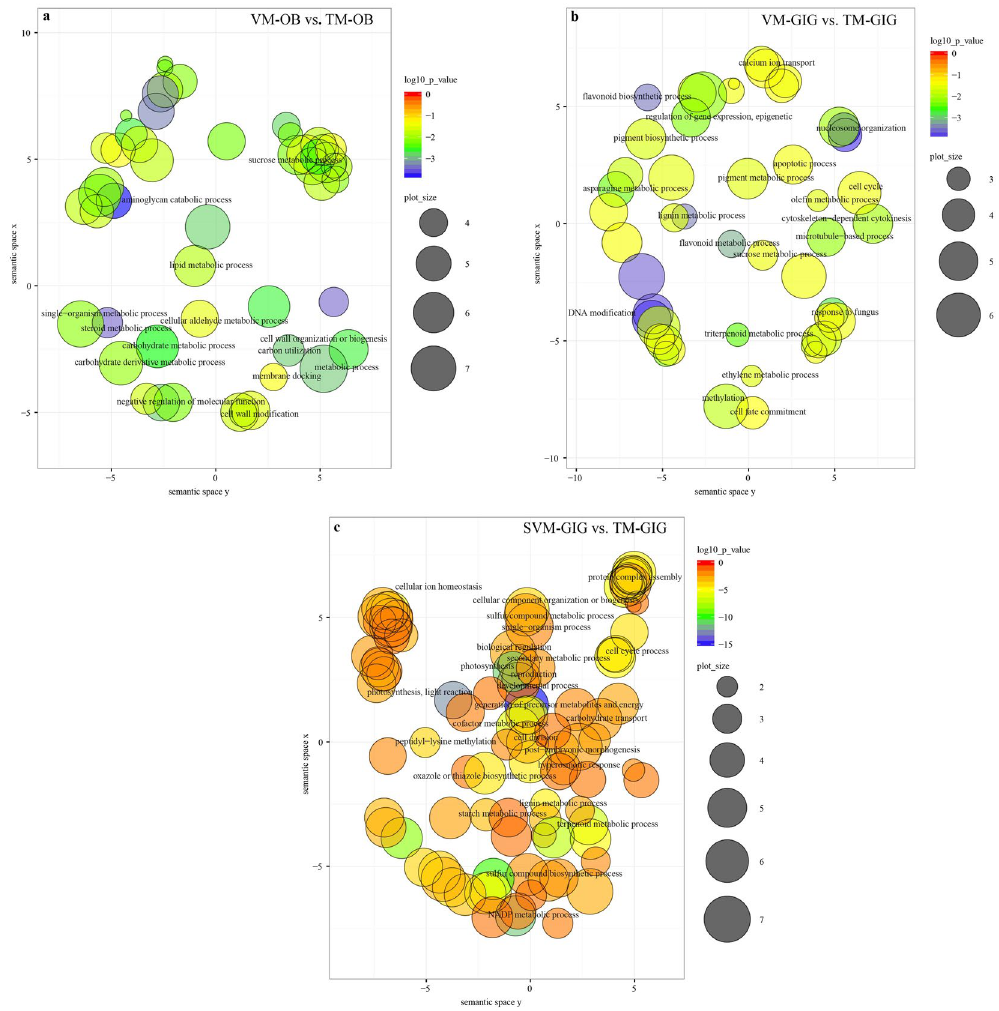
Figure 1. Scatterplot of enriched GO terms in pairwise comparisons. The scatterplot of enriched GO terms (p < 0.05) in biological process in the VM-OB vs. TM-OB comparison ( a ), in the VM-GIG vs. TM-GIG comparison ( b ), and in the SVM-GIG vs. TM-GIG comparison ( c ). Bubble color indicates the p-value of GO term; bubble size indicates the frequency of GO terms in the underlying GOA